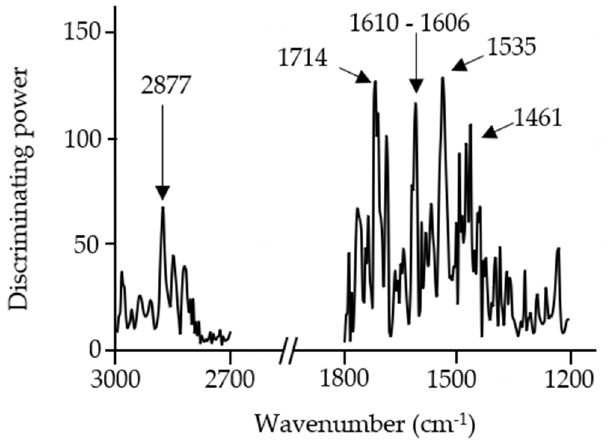
Figure 7. Soft independent modeling of class analogy discriminating power plot of FTIR spectroscopy spectra (3000–2700 cm − 1 and 1800–700 cm − 1 ) from a 6-class SIMCA A. diaperinus vs. L. migratoria dough model. Table 7. Soft independent modeling of class analogy (SIMCA) interclasses distances from a 6-class SIMCA A. diaperinus vs. L. migratoria doughs